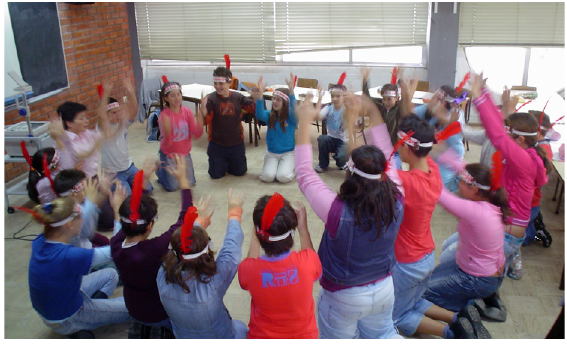
3 | Fig. 3: 4th graders learning a popular Canadian Indian song.